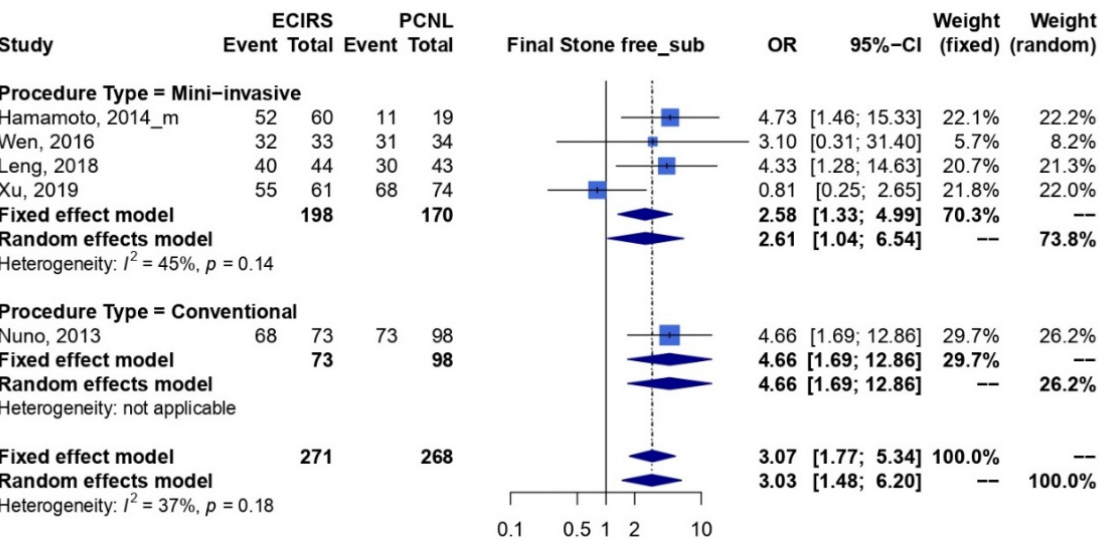
Figure A1. Subgroup analysis of outcome regarding initial stone free rate. (Mini: [17–19][22,23]; Conventional: [20,21]).